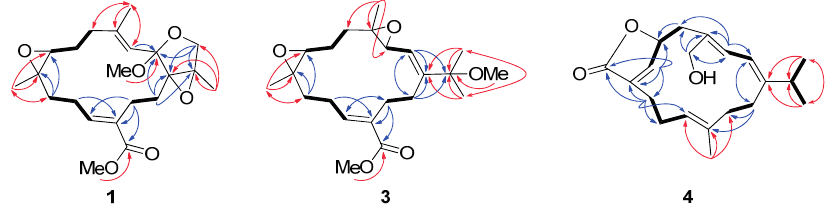
Figure 2. Selected 1 H − 1 H COSY ( ▬ ) and HMBC ( → ) correlations of 1 , 3 and 4